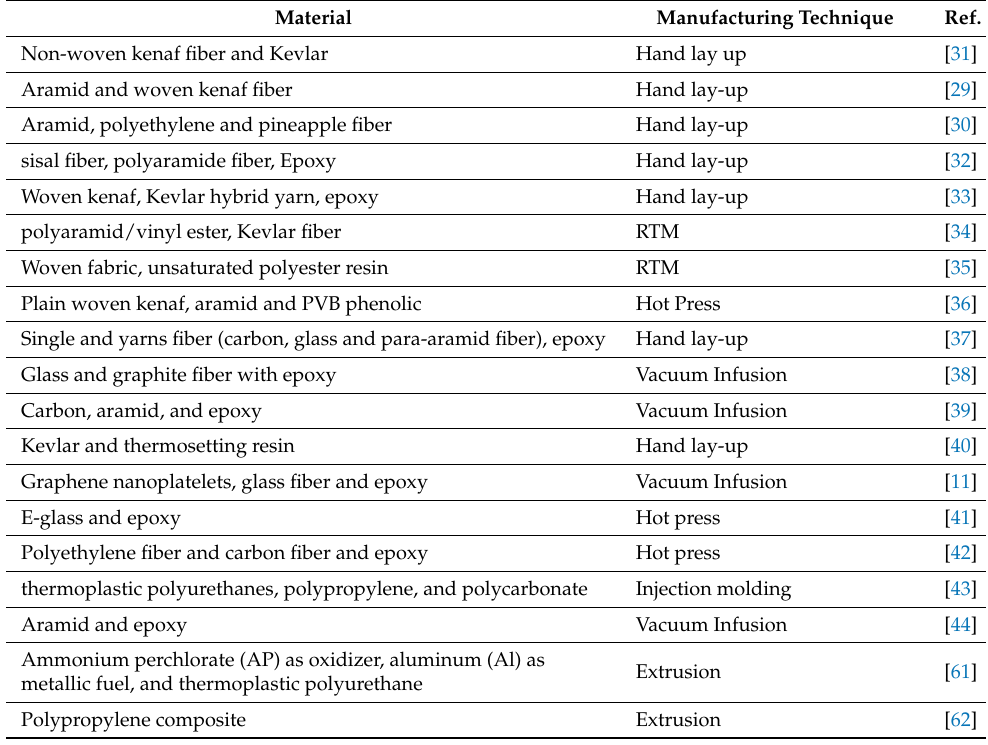
Table 4. List of various manufacturing technique in ballistic